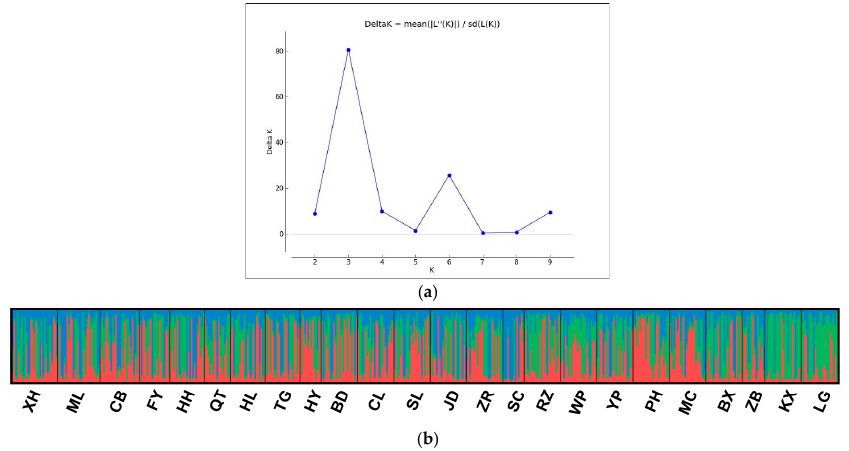
Figure 2. ( a ). Estimates of optimal K (number of clusters) from Δ K . ( b ). The structure bar shows the results of the Bayesian analysis of 24 populations of S. litura . Each individual is shown by a verti- cal bar. Blue, green and red represent the three clades.